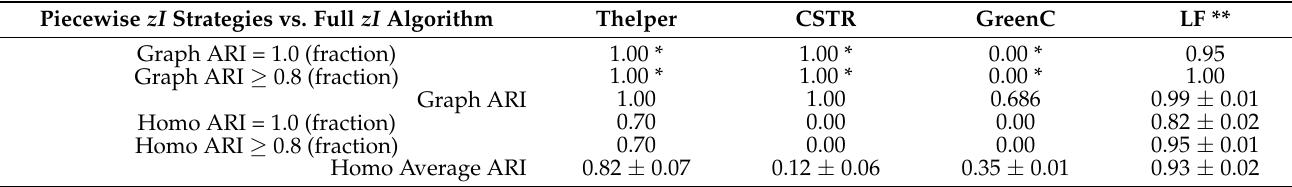
Table 1. The results of the computation of the adjusted Rand index (ARI) among the groupings calculated by full RI method— identified here as the “ground truth”—and the corresponding groupings of the piecewise-graph RI strategy (“graph”) and of piecewise-homo RI strategy (“homo”), for the cases T_helper, CSTR, Green Community and Leader-Follower. The lines show the fraction of times the given strategy has reported an ARI exactly equal to 1.0 or greater than 0.8 and the average of the ARI